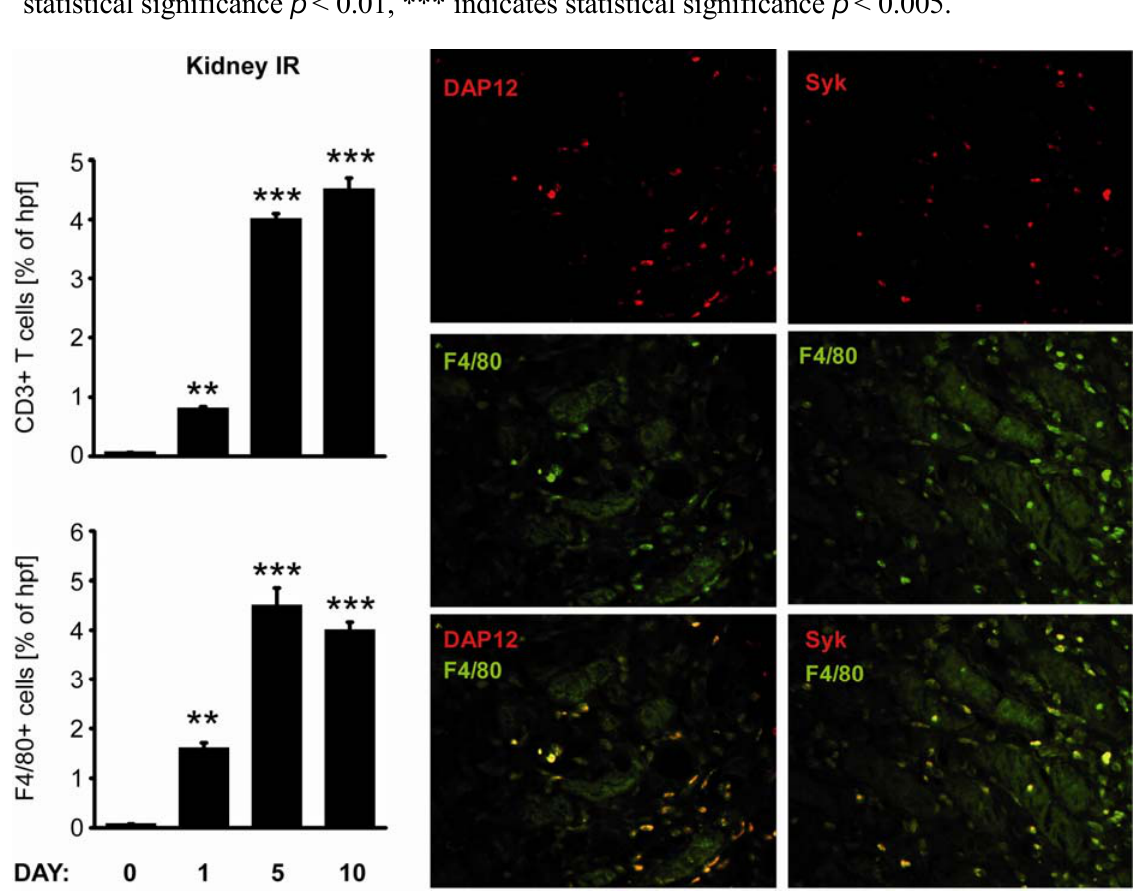
Figure 4. Renal leukocyte recruitment upon renal ischemia-reperfusion injury. Kidneys were obtained from all IRI mice at various time intervals as indicated. Immunostaining for macrophages and T-cells was performed on renal sections as described in material and methods. Data represents positive stained surface in percent and are shown as mean ± SEM from 8 to 12 mice (at least 25 hpf) of each group. F4/80, DAP-12 and Syk immunostainings were performed on paraffin embedded renal sections, obtained from mice 10 days after IRI, as described in material and methods. Data shows most representative results from each group. Data in histograms represents means ± SEM. ** Indicates statistical significance p < 0.01, *** indicates statistical significance p <